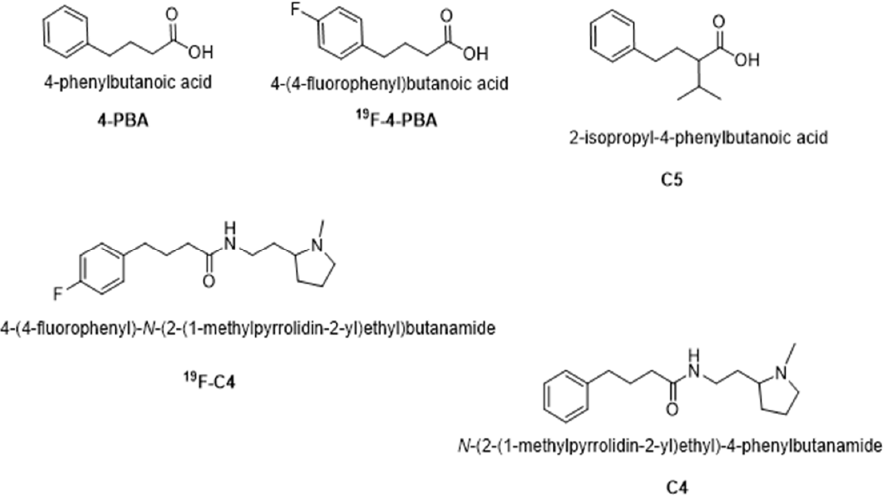
Figure 1. Molecular structures of 4-PBA, 19 F-PBA, C4, 19 F-C4, and C5.